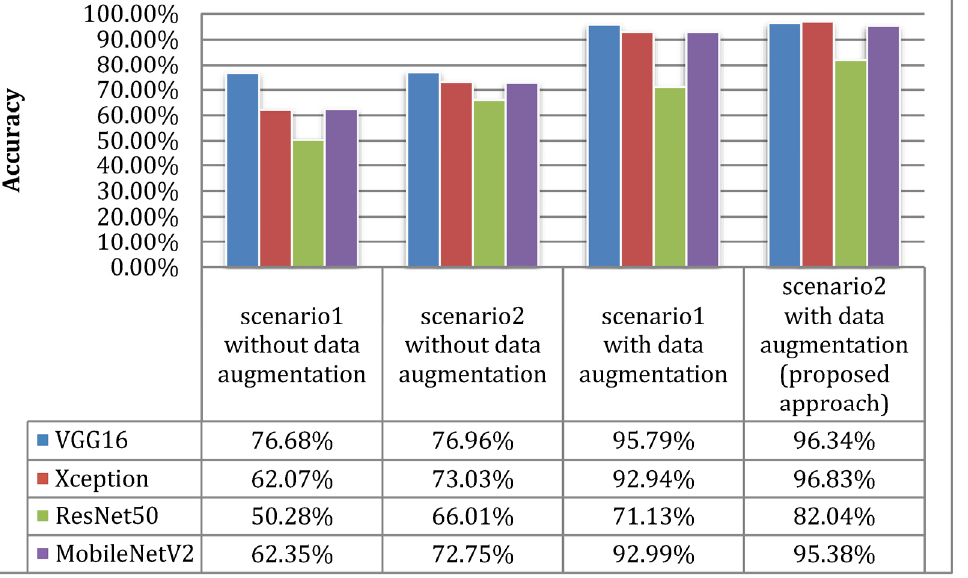
Figure 16. Comparing the accuracy metric of Scenario1 and Scenario2 with and without the use of data augmentation.